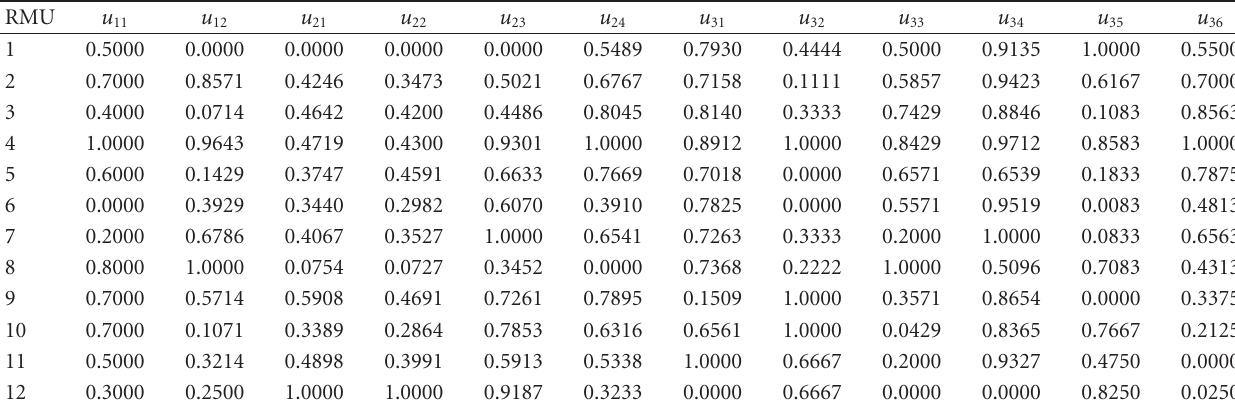
Table 3: The standardized decision